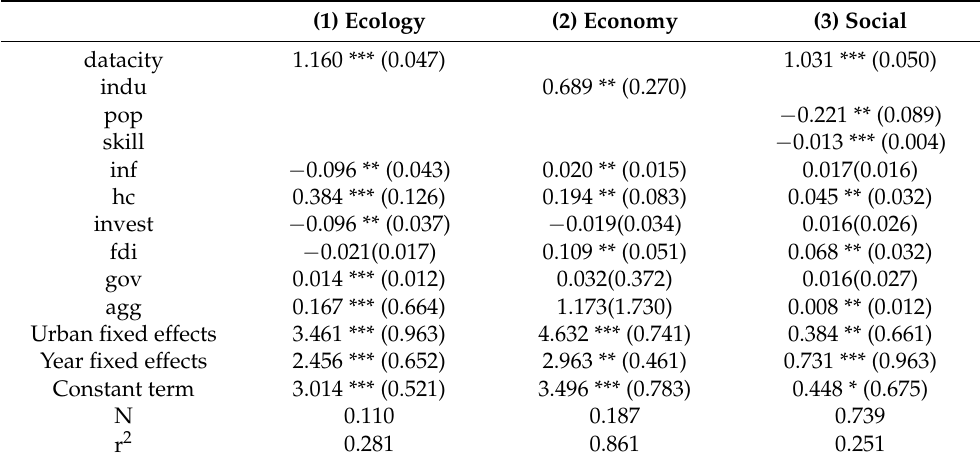
Table 5. Robustness test